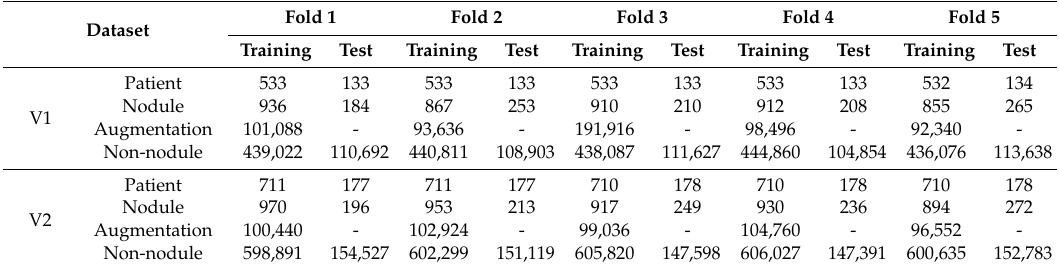
Table 2. Statistics of the dataset used for five-fold cross-validation.